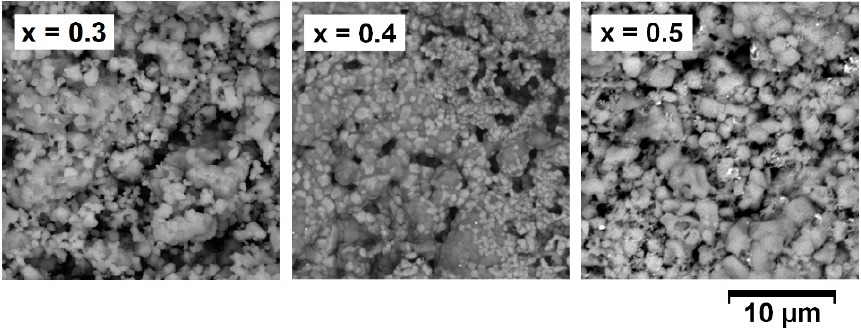
Figure 3. SEM images (BSE mode) of the surface of CaV 1–x Mo x O 3– δ (x = 0.3, 0.4, 0.5) ceramic samples.